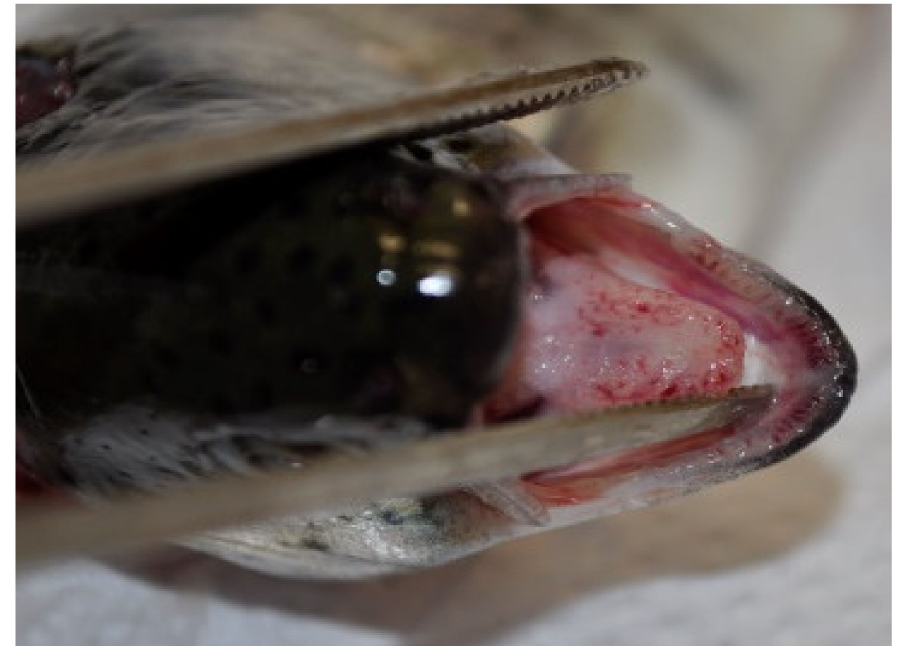
Figure 3. Small petechiae visible in the oral cavity.